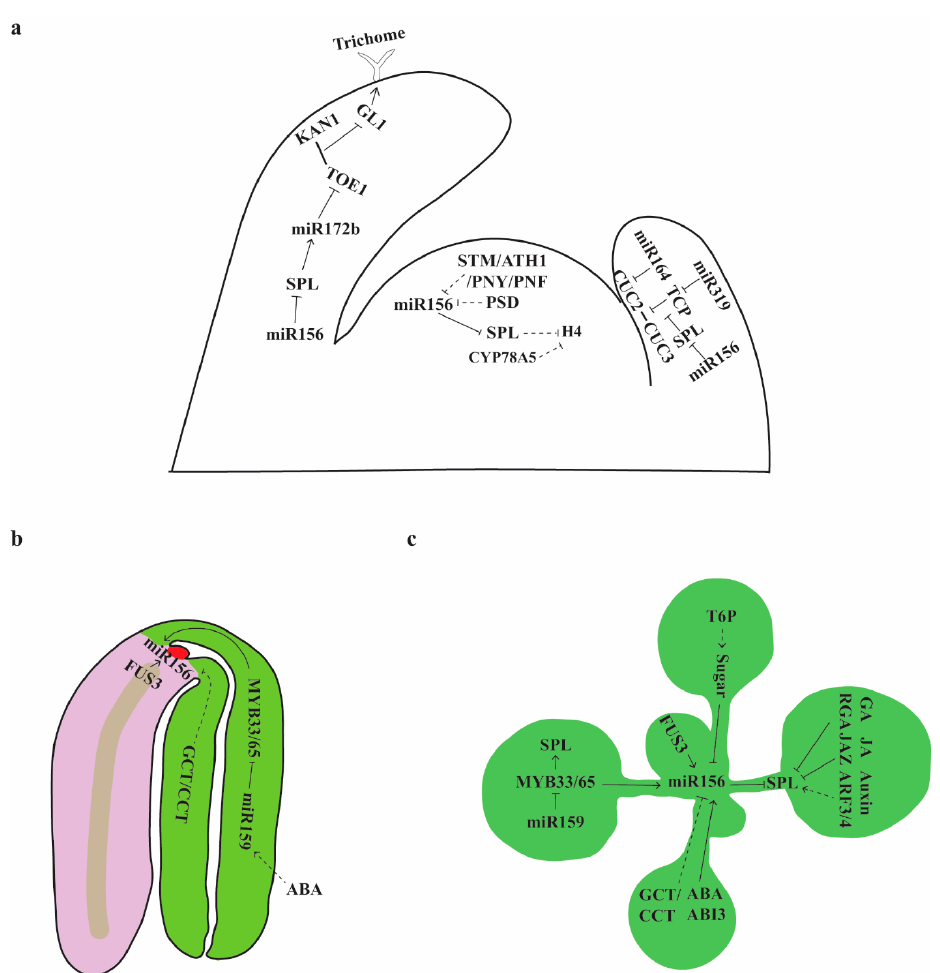
Figure 2. Spatial and temporal regulation of vegetative phase change.( a ) Shoot apical meristem (SAM) regulators and vegetative phase change. miR156 and SPL s are expressed in the shoot apical meristem, leaf primordia, expanding leaves, and expanded leaves. In juvenile tissues where levels of miR156 are high, SPL s are repressed. In adult tissues where levels of miR156 are low, SPL s are derepressed. WUS, STM, ATH1, PNY, PNF and PSD repress miR156 in the SAM. In leaves, miR156-targeted SPLs activate miR172b , which repress a group of AP2 transcription factors. TOE1, a member of the miR172-targted AP2 family, physically interacts with leaf abaxial identity regulator KAN1 and forms a repressing loop at the trichome initiation gene GL1 . CUC genes are expressed at the boundary of leaf primordia and the SAM, and physically interact with each other to promote serration in expanded leaves. CUC2 is repressed by miR164, miR319-targeted TCP interferes with the interaction between CUC2 and CUC3, and miR156-targted SPLs bind to TCP to release CUC from TCP to promote leaf serration. SPL and CYP78A5 repress H4 to control leaf initiation.( b ) Regulation of miR156 in embryo. miR156 is highly expressed in the embryo by the activities of MYB33/65 and FUS3, while GCT/CCT repress miR156. ( c ) Regulation of miR156 and SPL in seedling. MYB33/65, FUS3, and GCT/CCT continue to act in seedlings and sugar produced from photosynthesis represses miR156. Hormones are involved in vegetative phase change by acting on SPLs directly or indirectly. The gibberellic acid (GA) signaling molecule RGA and the jasmonic acid (JA) signaling molecule JAZ directly interact with miR156-targeted SPLs and repress their activities. The abscisic acid (ABA) signaling molecule ABI3 represses SPL via activating miR156. The auxin signaling molecules ARF3 and ARF4 suppress precocious vegetative phase change and it is not known if they act on SPLs directly or